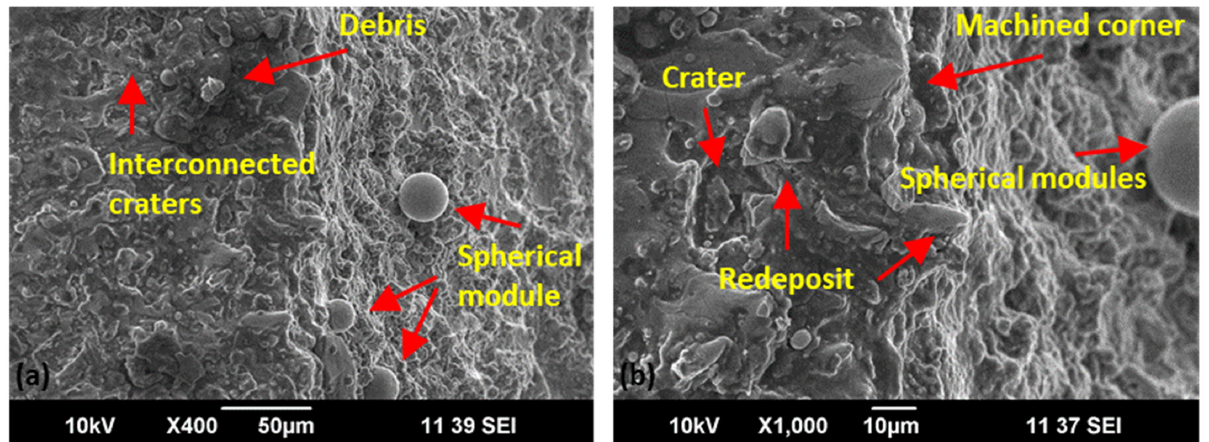
Figure 16. Scanning electron microscopic analysis of concave geometry for optimal parametric set- ting (V S 50 V, F P 4 kg/cm 2 , Ø N 8 mm, and W D 10 mm) at X400 ( a ) and X1000 ( b ).